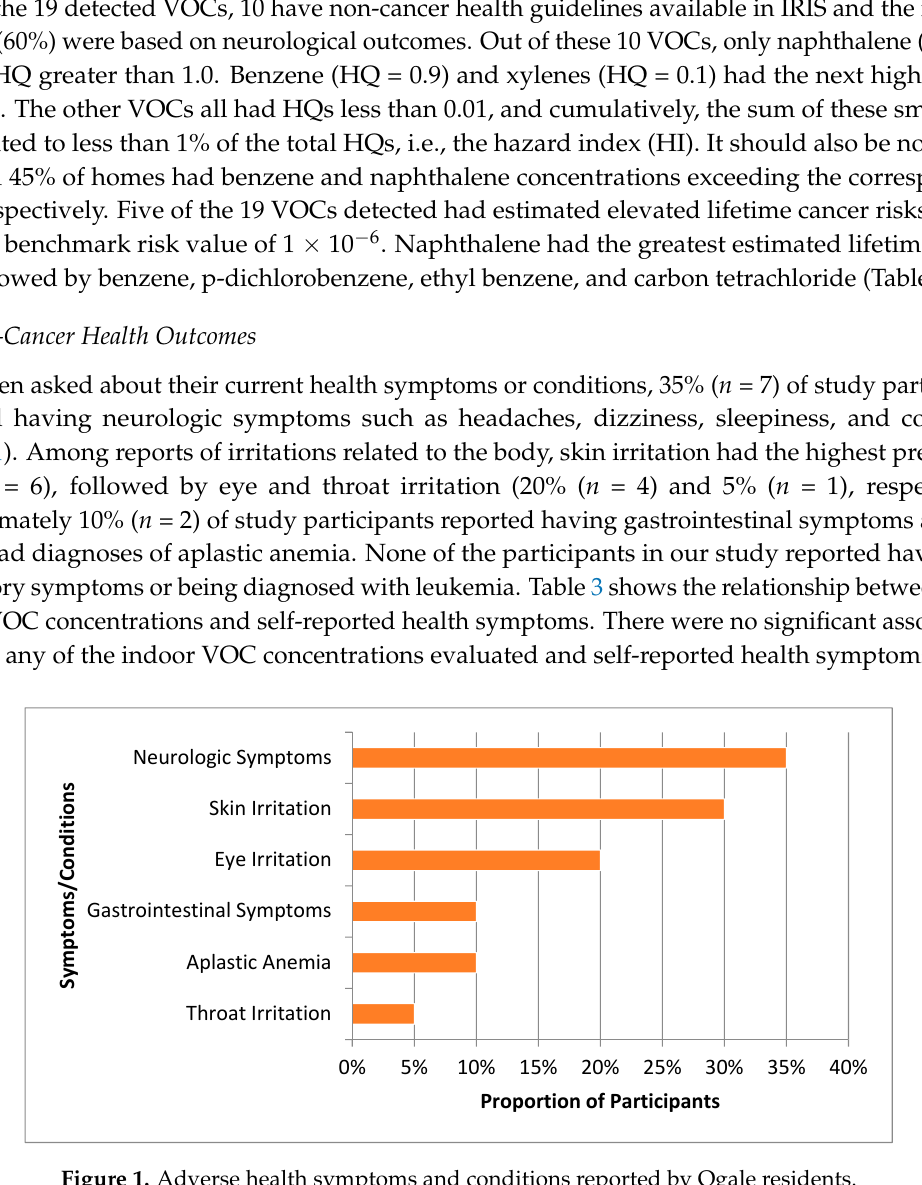
Figure 1. Adverse health symptoms and conditions reported by Ogale residents.